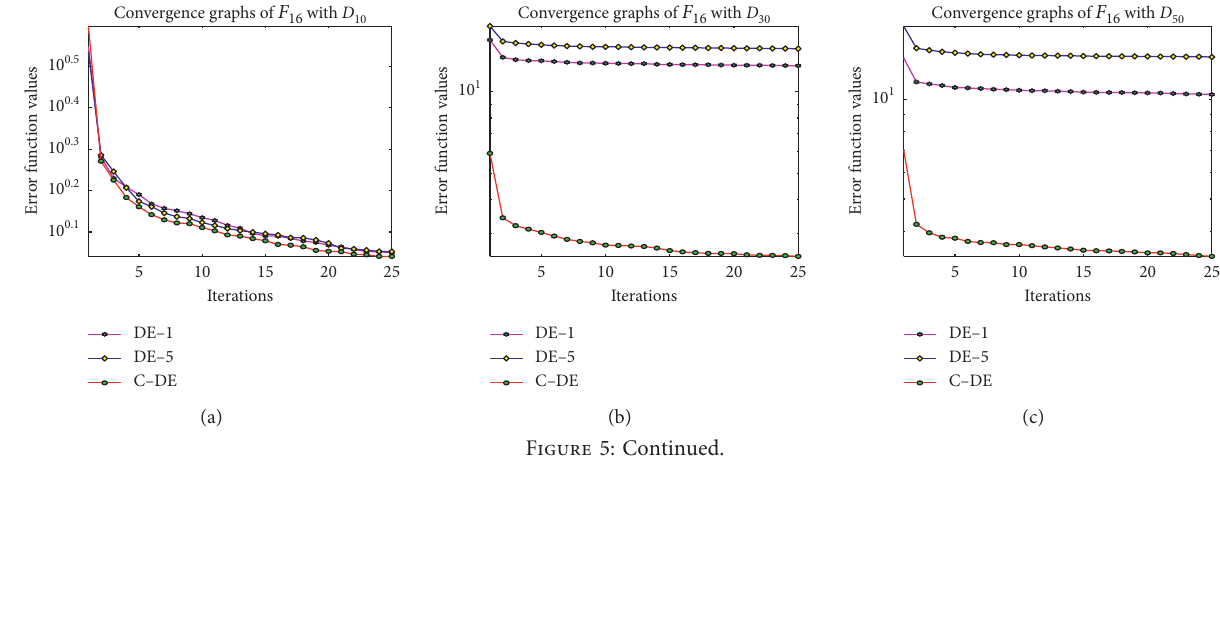
to F solved with DE-1, DE-5, and C-DE in n � 10, 30, and 50 dimensions. 11 15